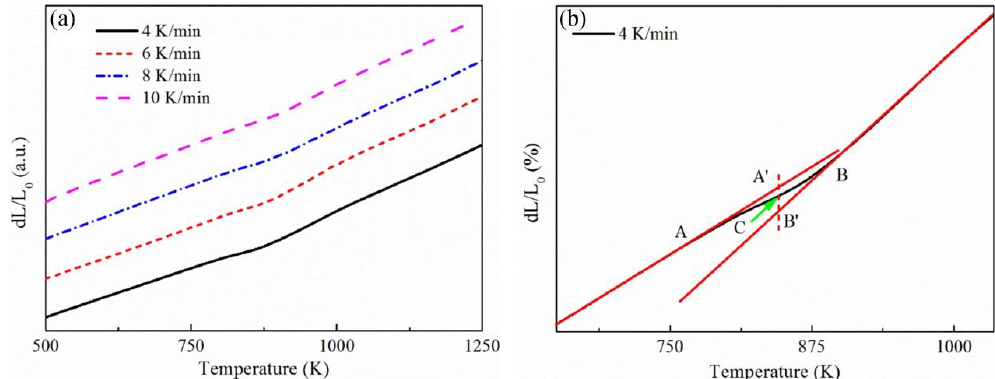
Figure 2. ( a ) The thermal dilation curves of Al 0.25 CoCrFeNi HEA measured at different heating rates and ( b ) an example of calculating f by level ruler method. The red lines are used for determine the starting (A) and ending (B) point of the phase transition, and the intersection (C) of the dashed line and the thermal expansion curve is used for the calculation of f using Equation (1).